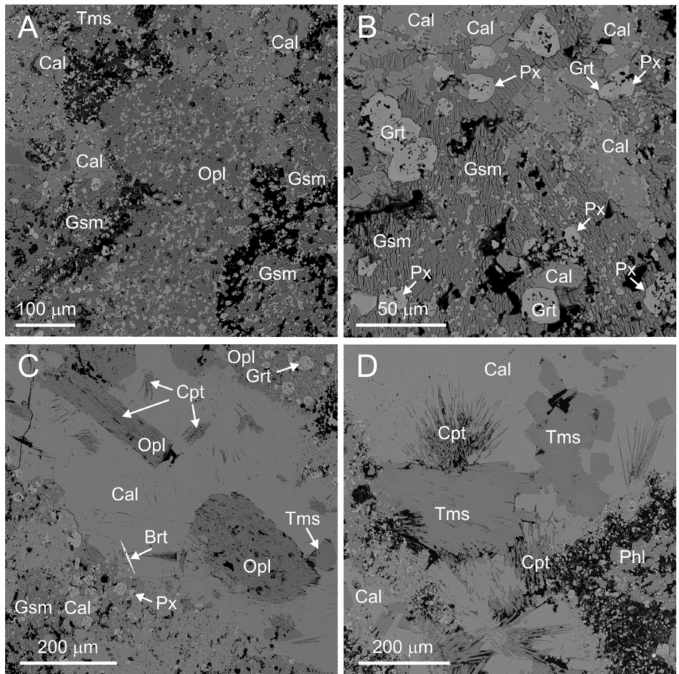
Figure 4. Mineral composition of the zeolite rock: ( A )—opal, calcite, and zeolites with dissemination of garnet of the grossular–andradite series and pyroxene of the diopside–esseneite series; ( B )—gismondine- Ca aggregates filling empties in rock; ( C , D )—calcite veins containing zeolites: ( C )—clinoptilolite-Ca aggregates and pseudomorphs of opal after prismatic mineral ( D )—thomsonite-Ca, clinoptilolite-Ca, and phillipsite-Ca. Brt—baryte, Cal—calcite, Cpt—clinoptilolite-Ca, Grt—garnet of the grossular–andradite series, Gsm—gismondine-Ca, Opl—opal, Phl—phillipsite-Ca, Px—pyroxene of the diopside–esseneite series,